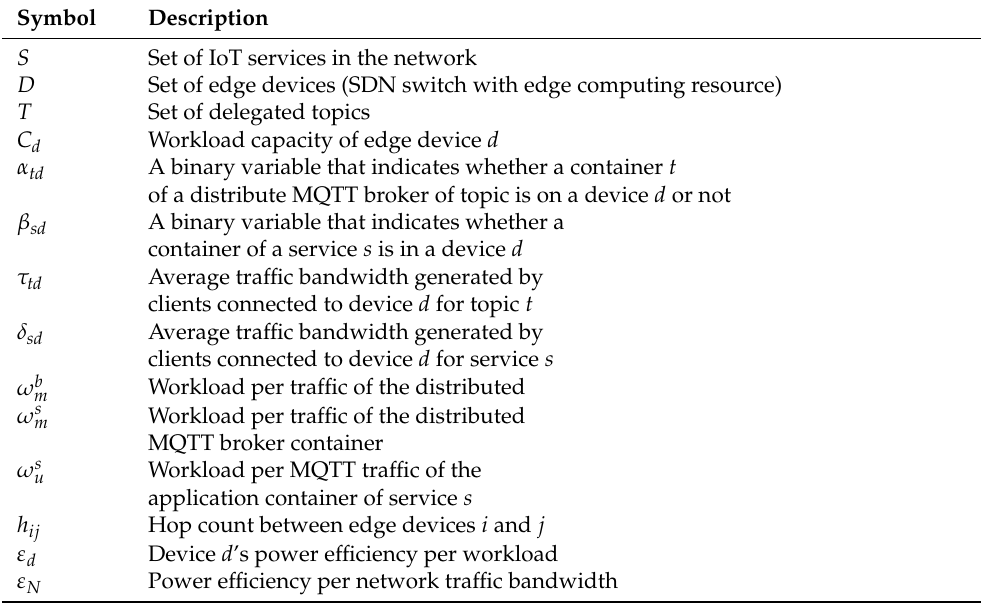
Table 1. Notations used in proposed optimization